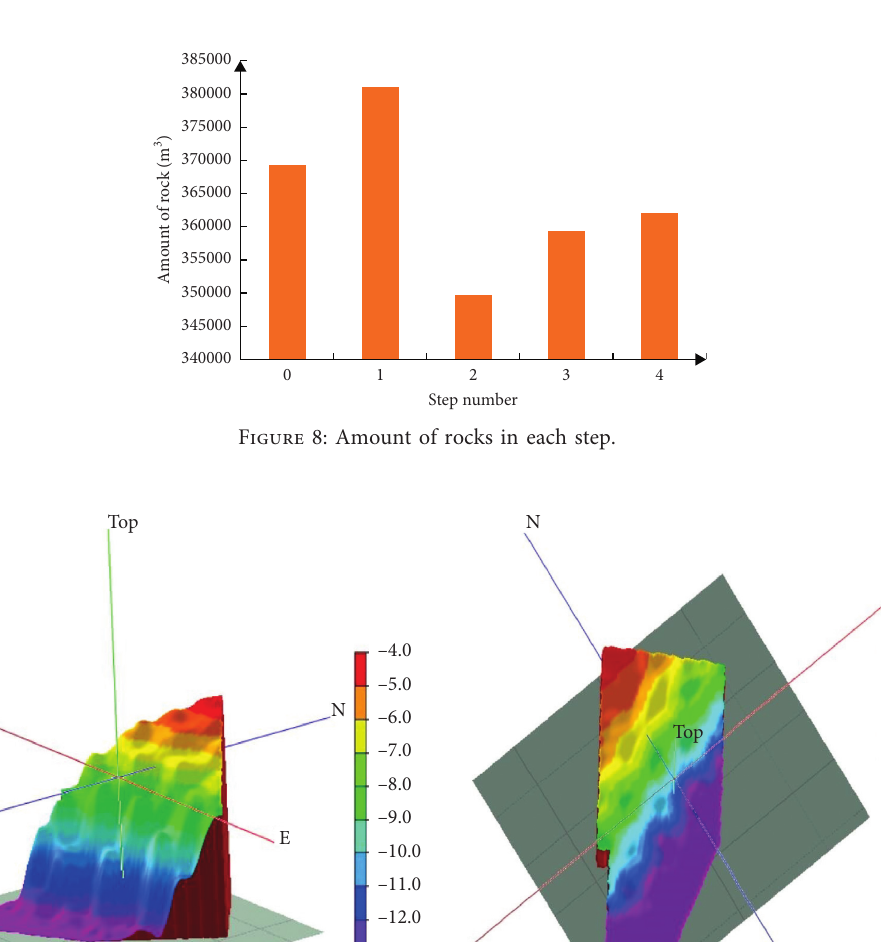
Figure 7: Steps of virtual drilling arrangement. (a) Step 1. (b) Step 2. (c) Step 3. (d) Step 4.